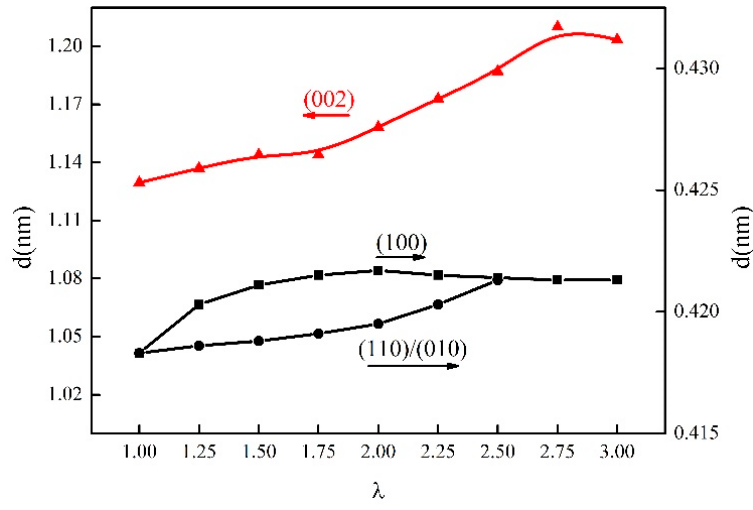
Figure 6. The d -spacing of the γ -PA1010 stretched at 120 °C.